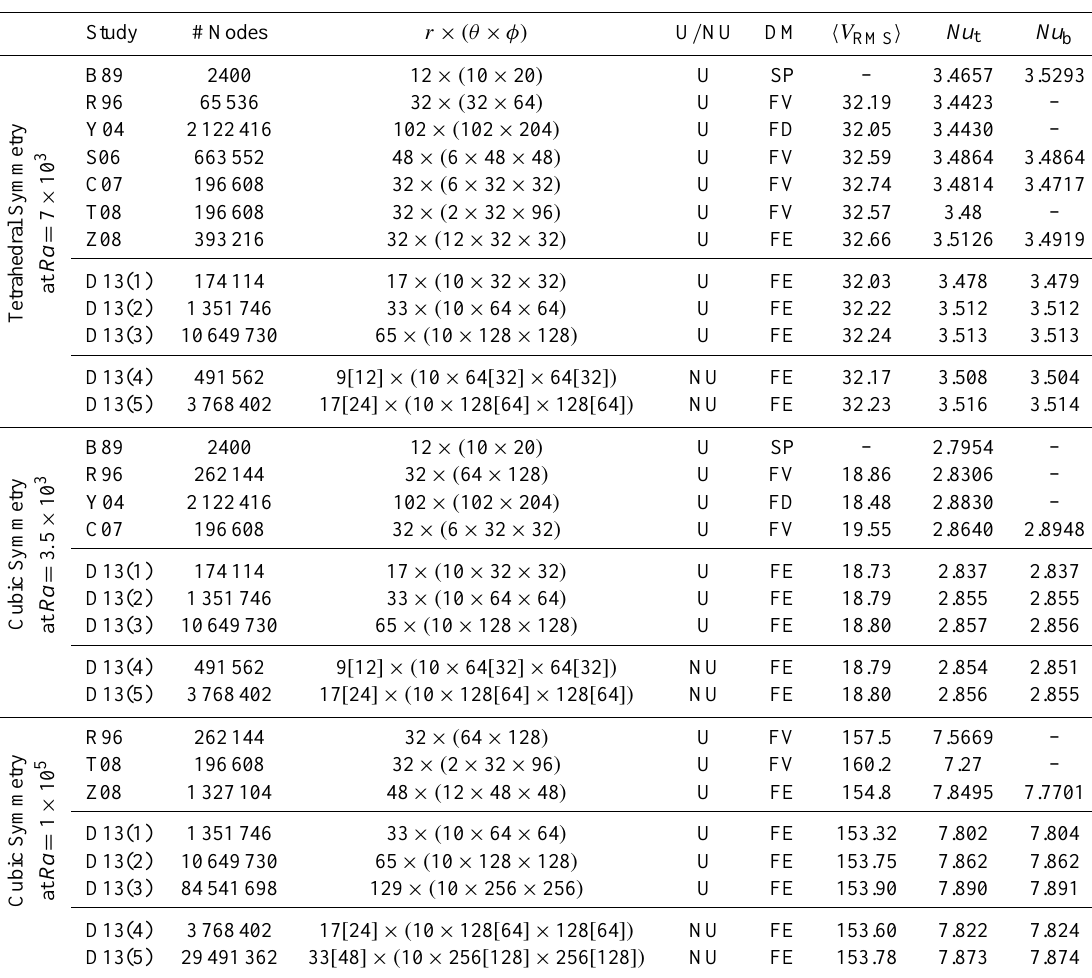
Table 1. Thermal amplitude benchmark comparisons for an isoviscous fluid. Abbreviations in the first column refer to the studies used for comparison: B89 (Bercovici et al., 1989), R96 (Ratcliff et al., 1996), Y04 (Yoshida and Kageyama, 2004), S06 (Stemmer et al., 2006), C07 (Choblet et al., 2007), T08 (Tackley, 2008), Z08 (Zhong et al., 2008). D13 is the present study. U / NU represents the grid configuration, with U being uniform and NU non-uniform. # Nodes denotes the total number of nodes, with a resolution of r × (θ × φ) in radial (and lateral) direction. For non-uniform cases, fine and [coarse] nodal resolutions are separated, using square brackets. The respective discretization method (DM) is listed, where SP indicates spectral, FE finite element, FD finite differences and FV finite volume. h V RMS i denotes the mean non-dimensionalized RMS velocity, whilst Nu t and Nu b represent the upper and lower boundary Nusselt numbers, respectively. Note that, theoretically, Nu t and Nu b should be